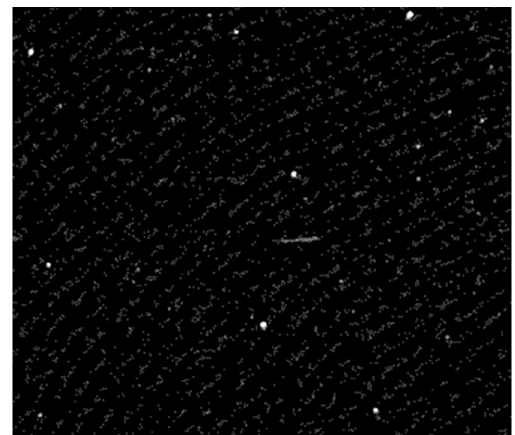
Figure 7. Detailed region after background subtraction.